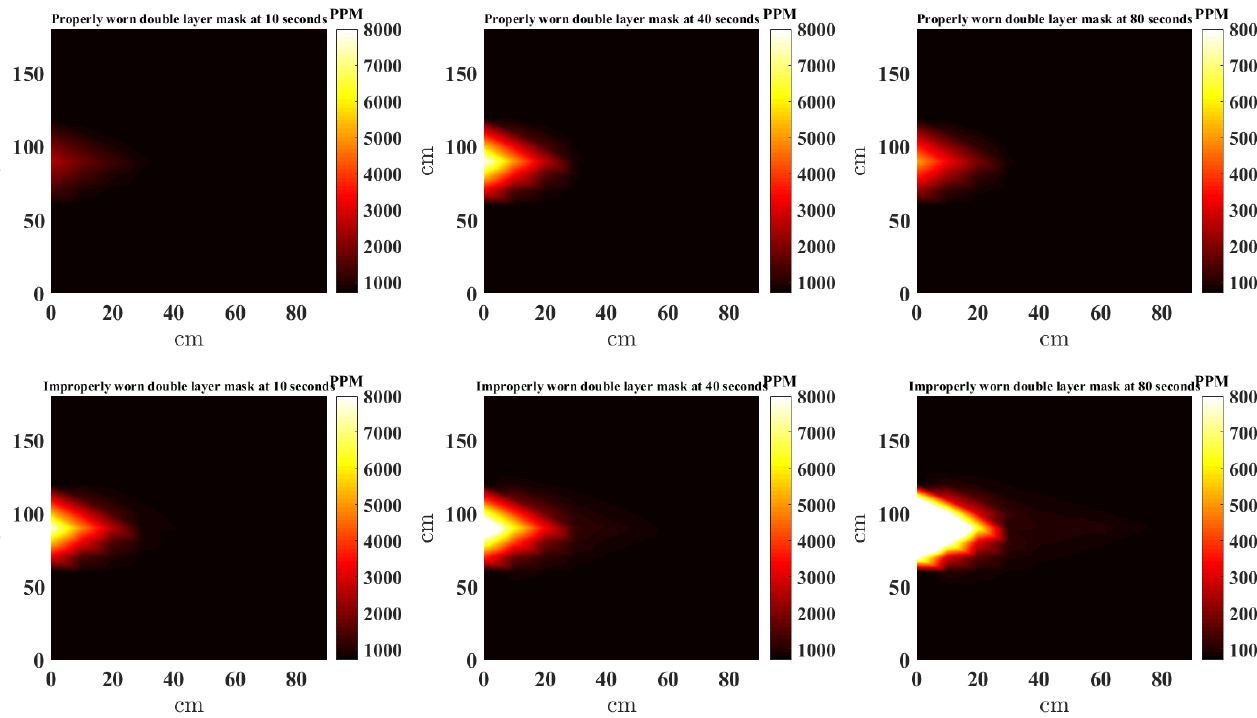
Figure 9. Interpolated CO 2 with properly and improperly worn double layer